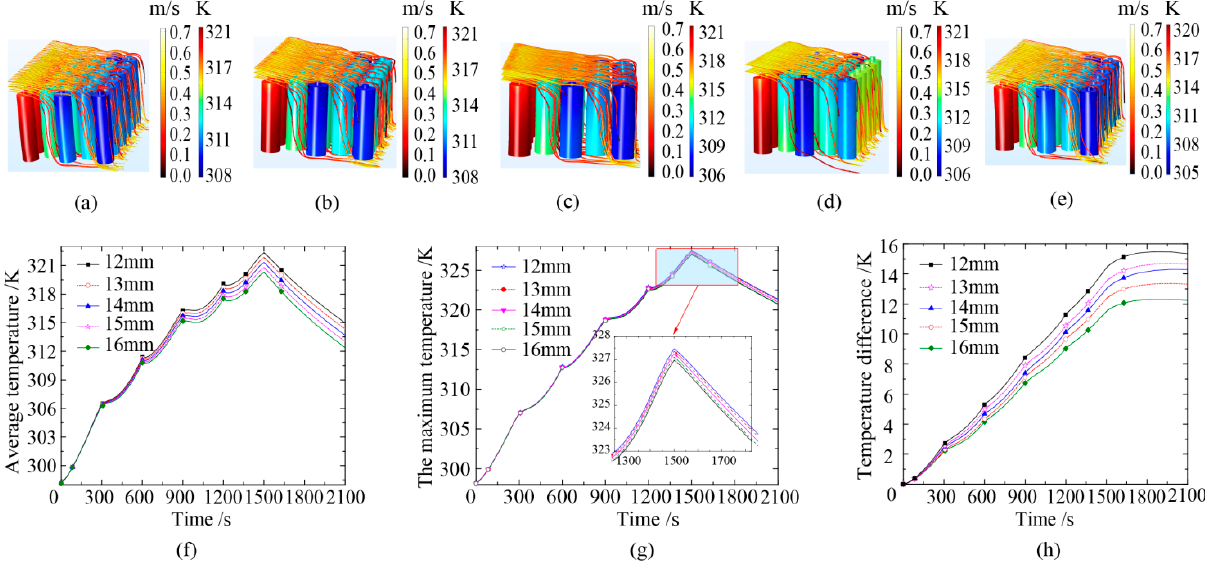
Figure 6. Thermal characteristic analysis. ( a ) Cloud chart of air streamline and battery temperature ( H = 12 mm); ( b ) cloud chart of air streamline and battery temperature ( H = 13 mm); ( c ) cloud chart of air streamline and battery temperature ( H = 14 mm); ( d ) cloud chart of air streamline and battery temperature ( H = 15 mm); ( e ) cloud chart of air streamline and battery temperature ( H = 16 mm); ( f ) relationship between the average temperature and time; ( g ) relationship between the maximum temperature and time; and ( h ) temperature di ff erence versus time.